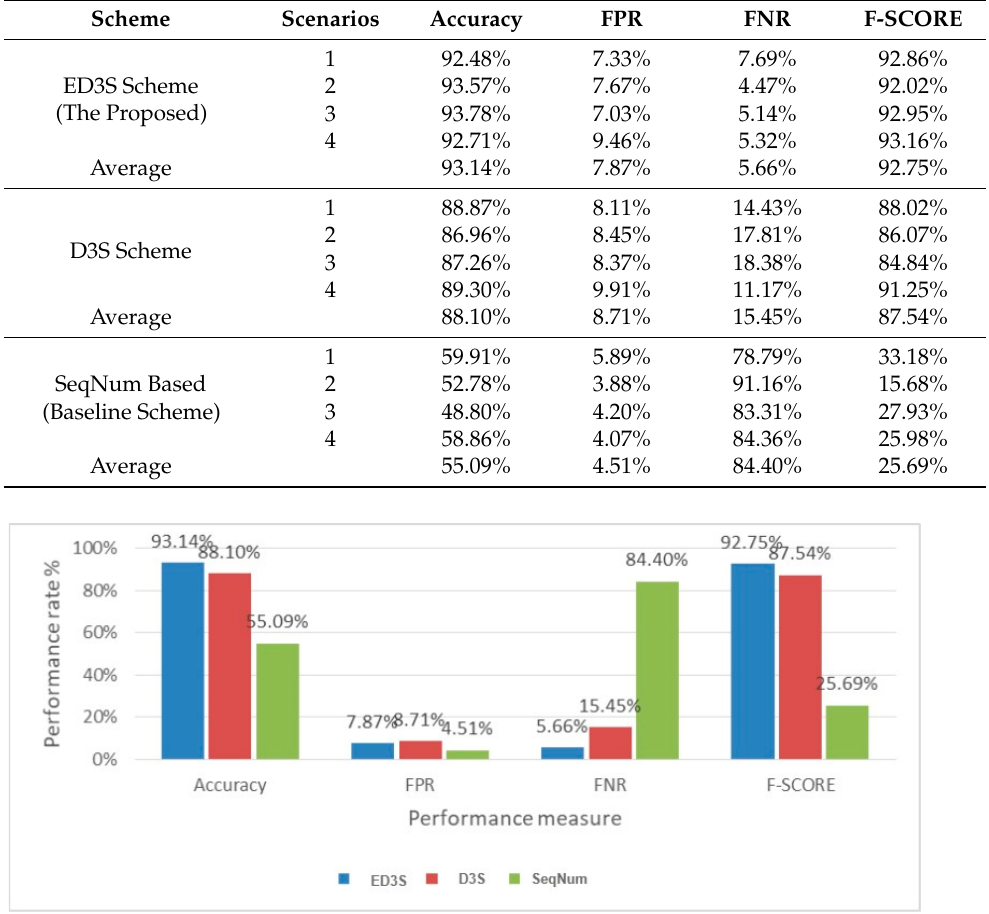
Figure 5. Comparison between ED3S, D3S, and SeqNum.